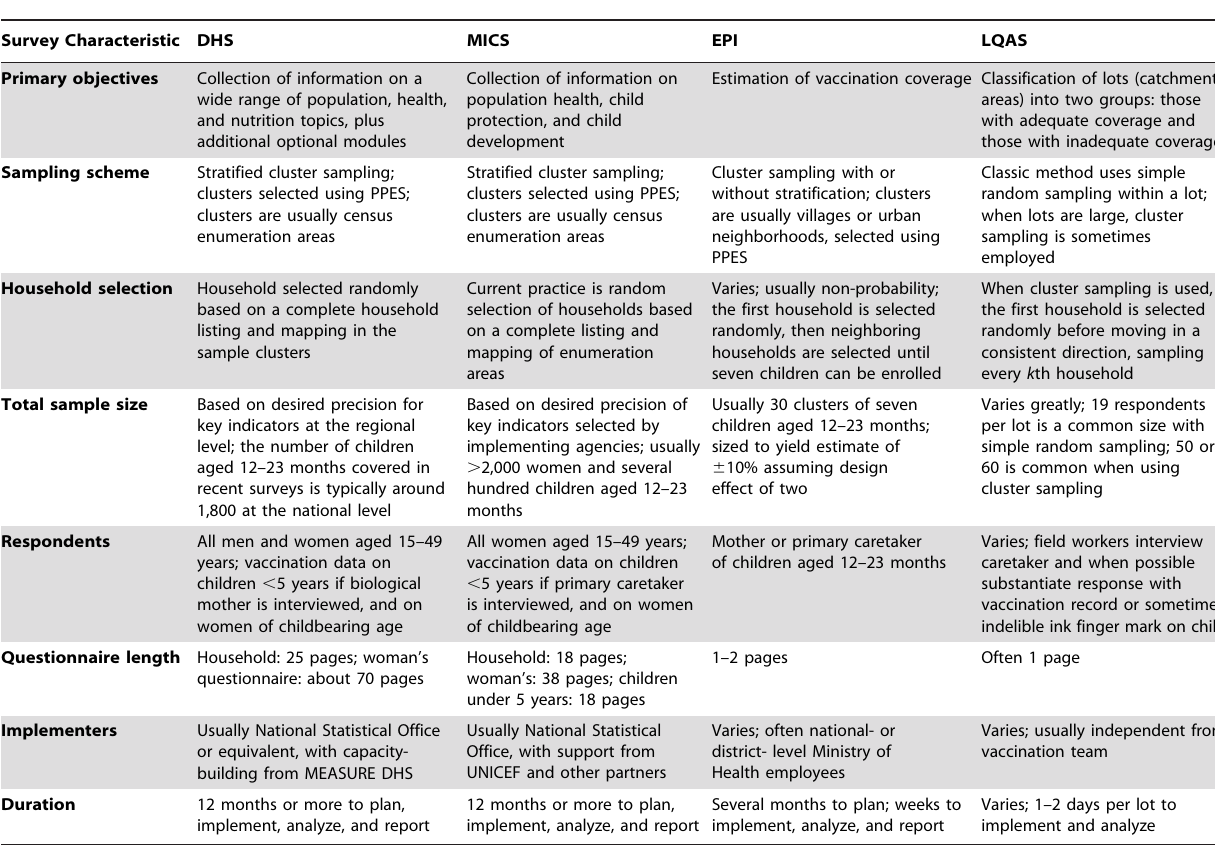
Table 1. Characteristics of common surveys used to measure